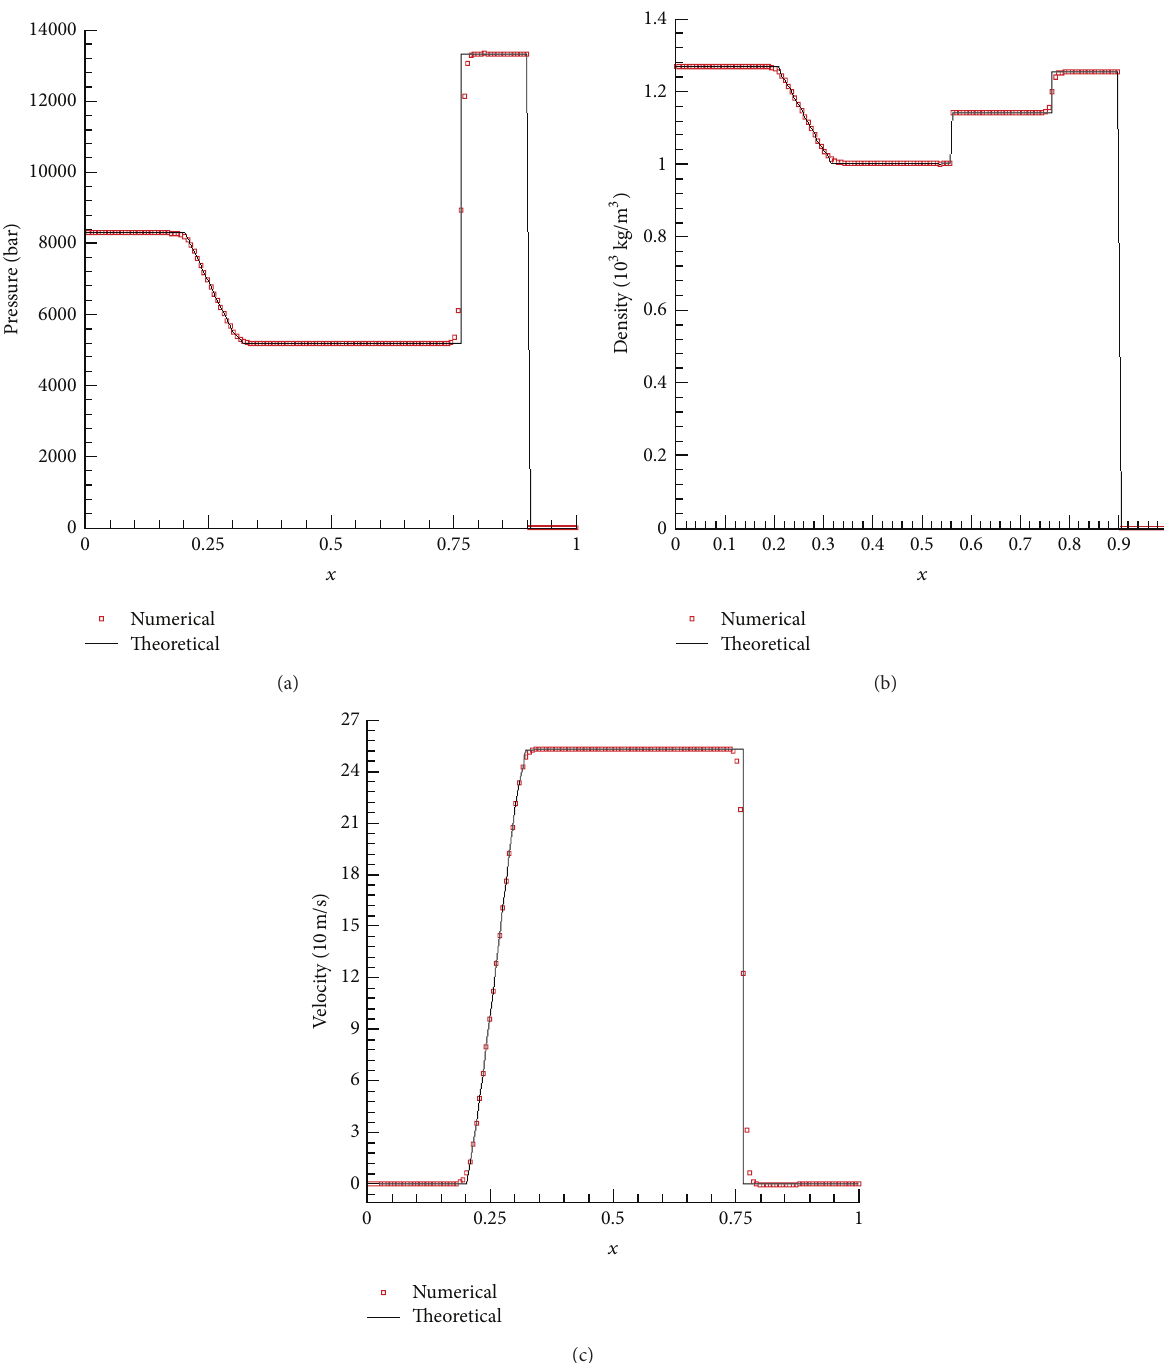
Figure 8: Numerical results by GFM-based algorithm at 𝑡 = 0.251 ms (Case